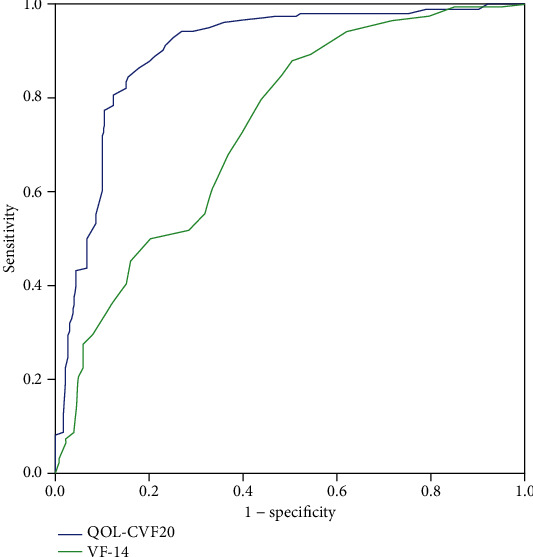
ROC analysis of QOL-CVF20 and VF-14 on NSBVA diagnostic in schoolchildren. The AUC of QOL-CVF20 was 0.901 (95% confidence interval 0.870-0.931), and the AUC of VF-14 was 0.738 (95% confidence interval 0.691-0.785).